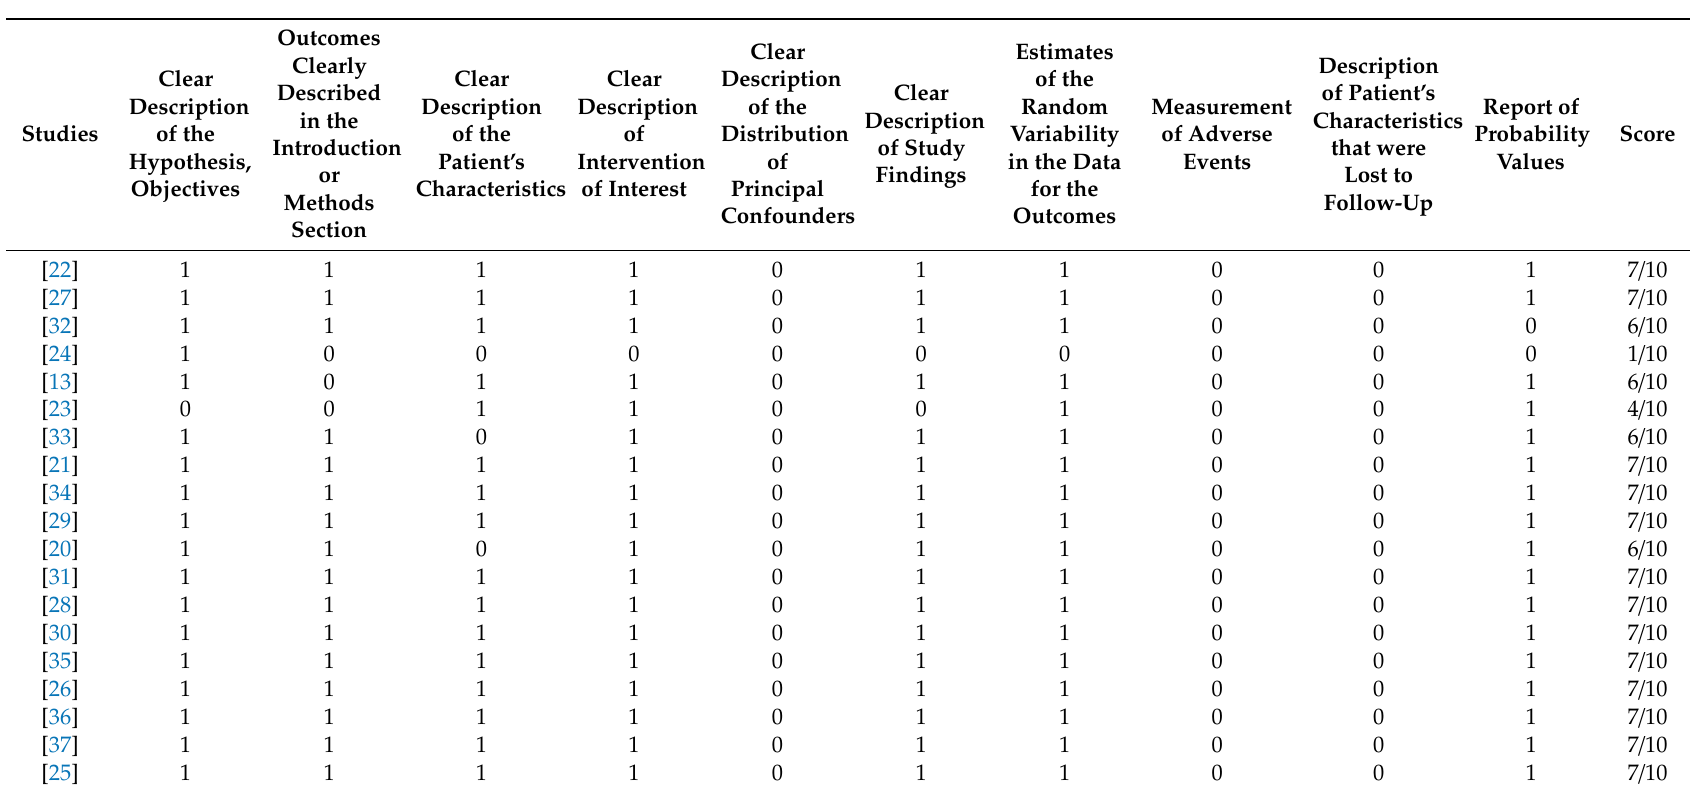
Table 3. Summary of the checklist for measuring quality of study